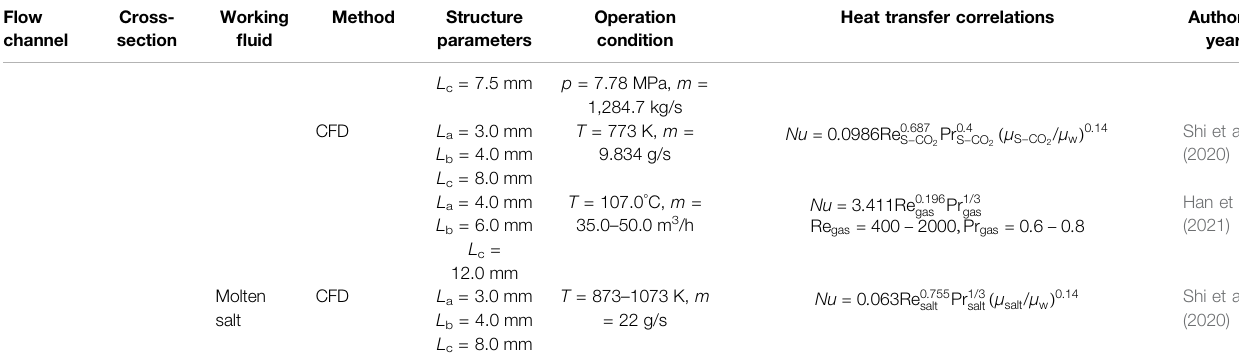
TABLE 2 | ( Continued ) Summary of heat transfer correlations for